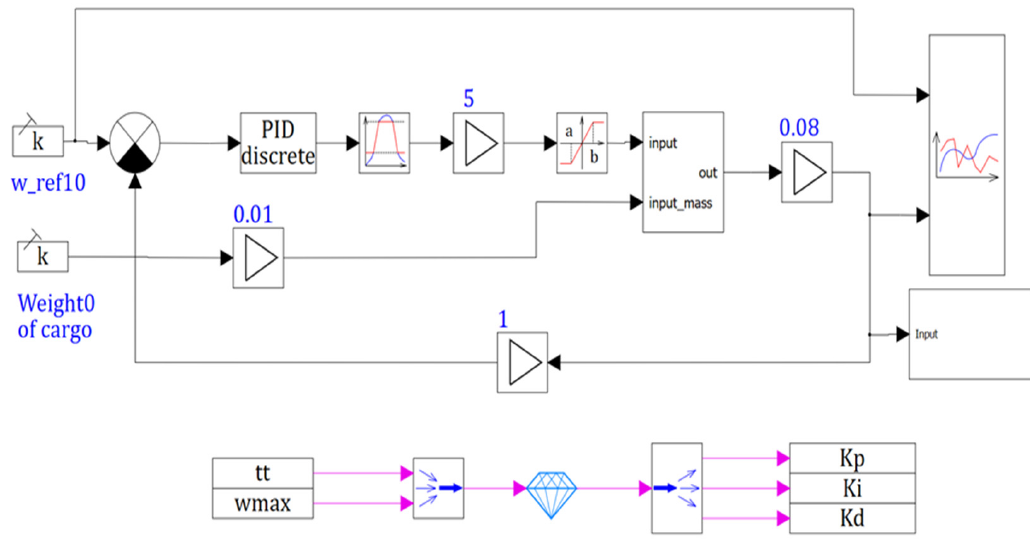
Figure 11. Schematic window with optimized continuous-discrete model with a mass of 2000 kg at a quantization period T = 0.01 s. Schematic window of the VI-IM submodel with additional load mass input is shown in Figure 12.